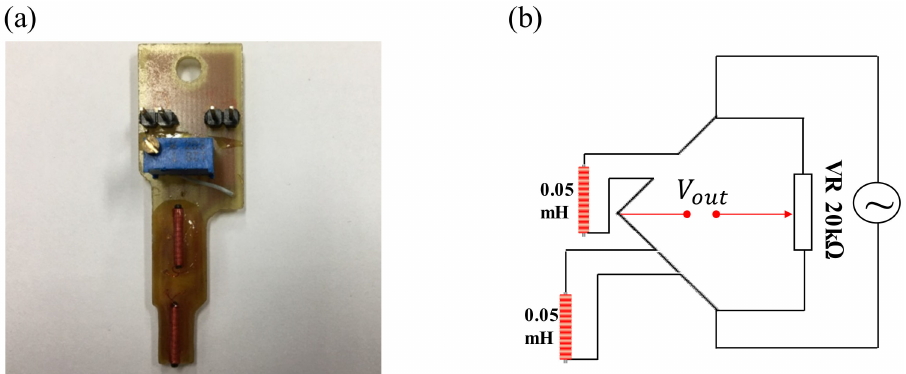
Figure 23. The coil-based probe: ( a ) the photograph and ( b ) circuit diagram of the coil probe.